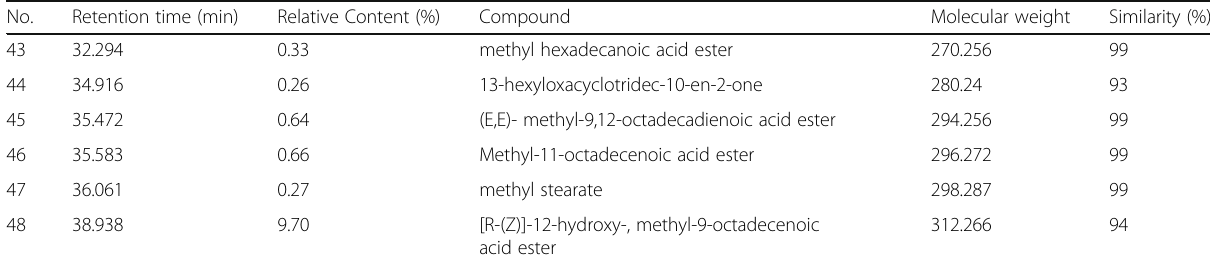
Table 1 Identified components of the compound essential oil